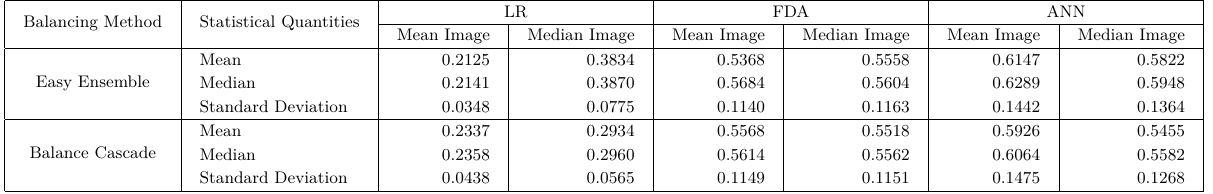
Figure 5. LSZ map obtained using weights from ANN, without data balancing (a) and with data balancing (b). The sample location with significant changes are marked with black circle. Table 3. Statistics (mean, median and standard deviation) for all the three methods using balanced